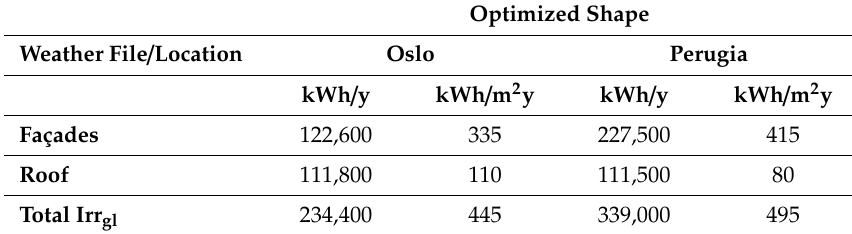
Table 10. Optimization performed by the Octopus evolutionary solver on solar analysis in Step 3